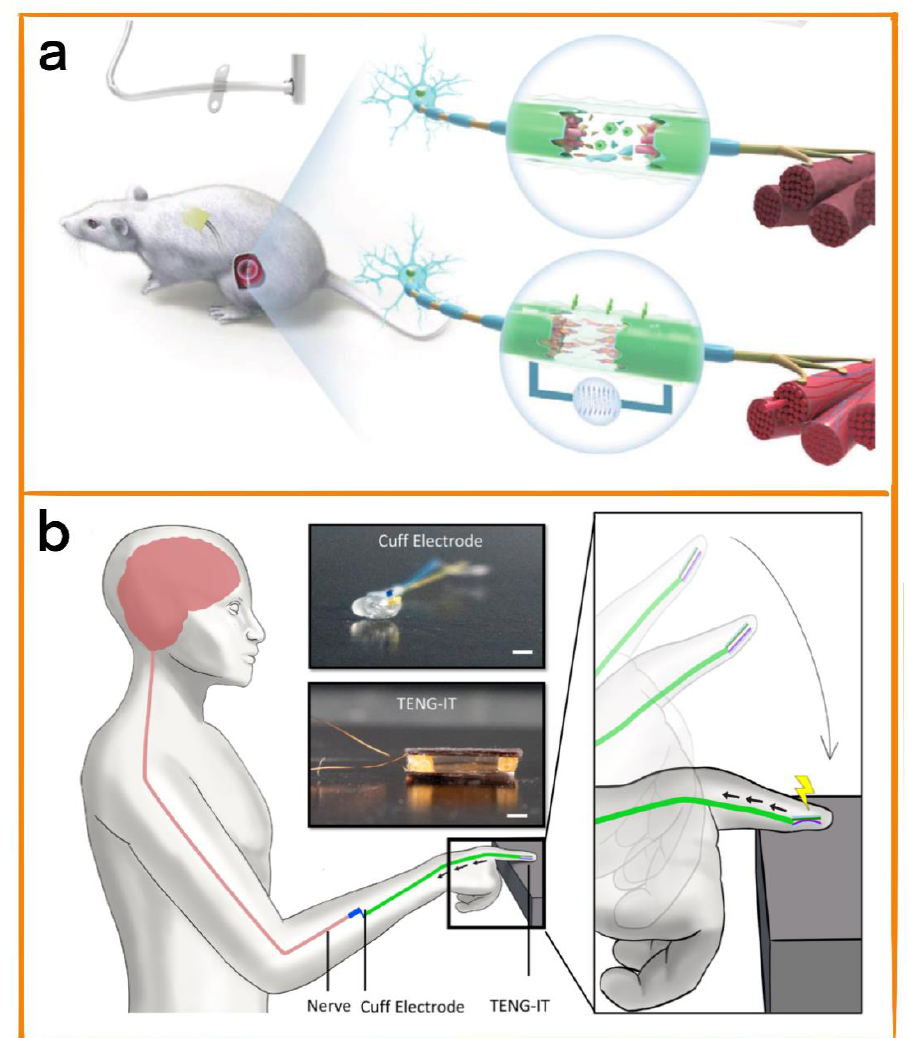
Figure 8. ( a ) Schematic diagram of electrode implant solution. Cut the skin, and introduce an electric stimulation cuff on the left sciatic nerve of the rats. Place Cs TENG as an energy collector at the waist of the rat, and connect the electrode with the encapsulated platinum wire to ensure that the damaged area is located between the two electrodes. Reprinted with permission from [69]. 2022, John Wiley and Sons. ( b ) Use of TENG-IT to restore touch. TENG-IT is implanted under the skin (desensitized fingers). Reprinted with permission from [70]. 2021, ACS.